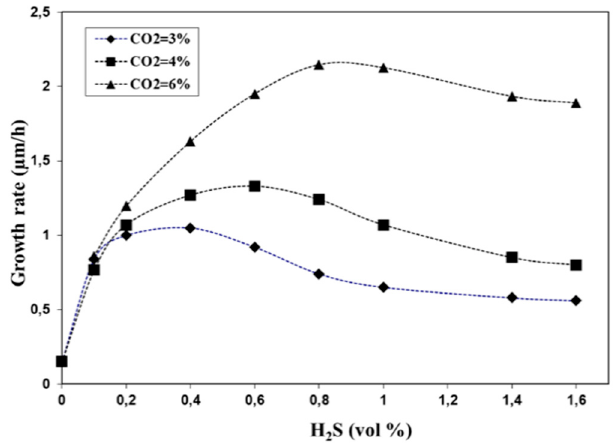
Figure 2. Growth rates of α -Al 2 O 3 coatings as a function of H 2 S at CO 2 = 3, 4 and 6 vol %.